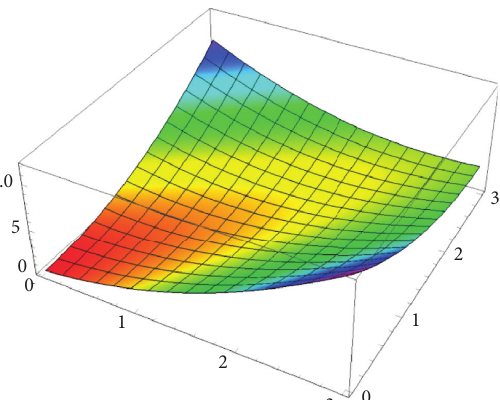
Figure 1: The graphical surface represents a 3D view of the function qp b ( σ , υ ) � max σ , υ { } + | σ − υ | for